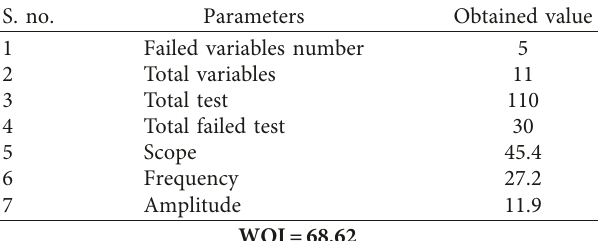
Table 4: CCME Method of WQI for